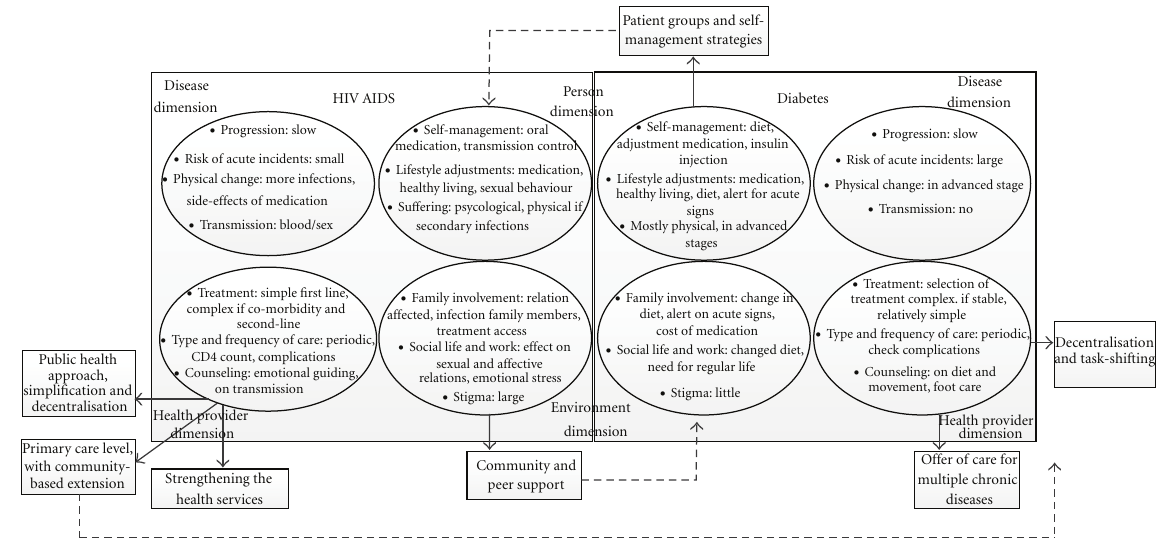
Figure 3: Potential cross-fertilisation of present care models of HIV/AIDS and diabetes, taken into account the chronicity dimensions.